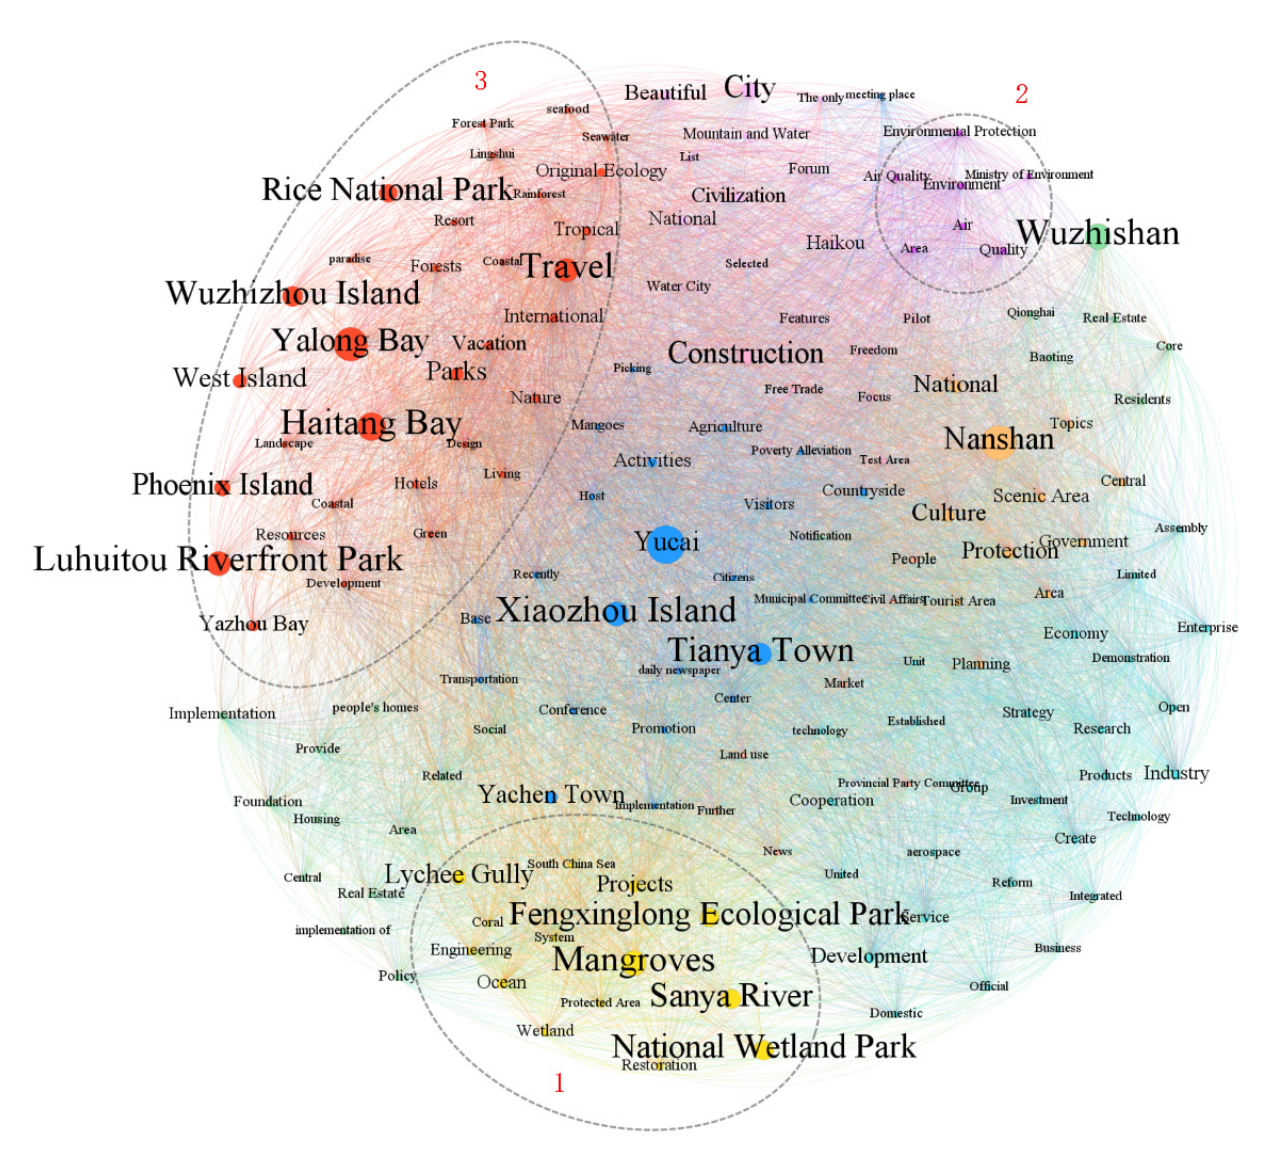
Figure 5. The social semantic network related to positive sentiments.